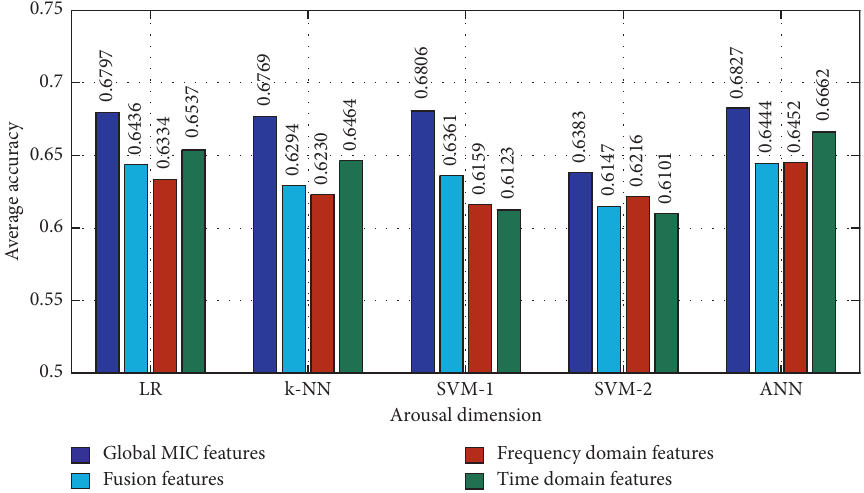
Figure 7: Average recognition accuracy of the four features in the arousal dimension using different